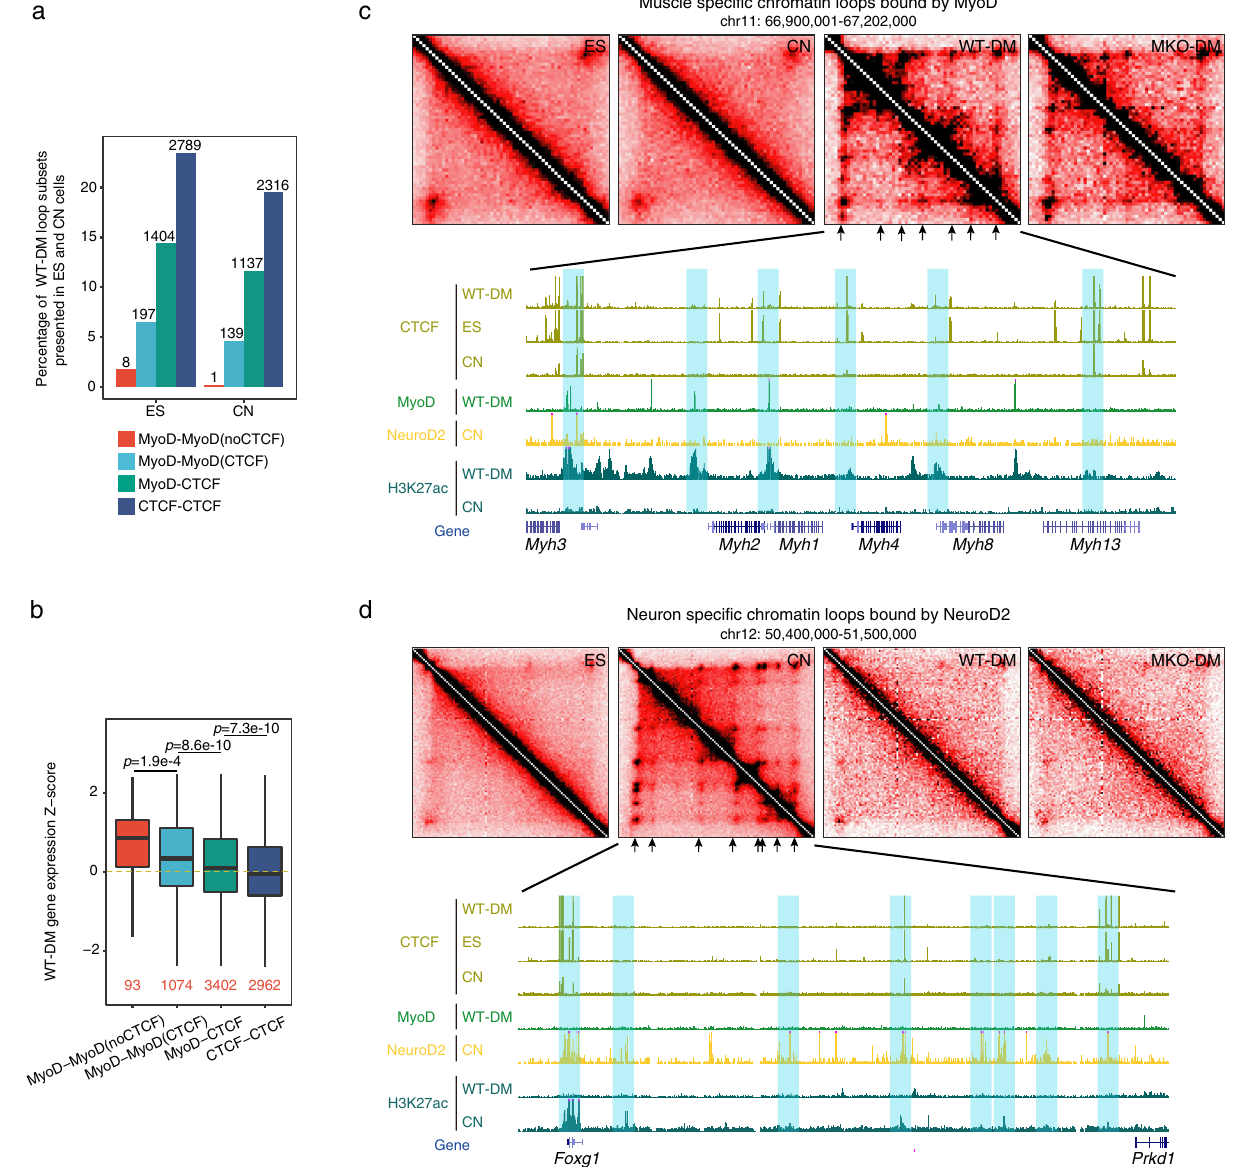
Fig. 4 MyoD anchors the formation of myogenesis-speci fi c chromatin loops. a Proportions of muscle chromatin loop subsets present in embryonic stem (ES) or cortical neurons (CN) cells. The numbers of muscle chromatin loops found in ES or CN cells are indicated for each bar. b Boxplots represent the expression Z-scores obtained in WT-DM cells for genes associated with each class of loops. The Z-score of each gene in WT-DM cells was calculated versus those in other ENCODE-collected cell types (ES, spleen, B, T, megakaryocyte, neural progenitor, and CN cells). The loop-related gene numbers are marked in red. p -values were calculated by the one-sided Wilcoxon rank-sum test. Source data are provided as a Source Data fi le. c Representative region showing muscle-cell-speci fi c loops anchored on MyoD-binding regions at the Myh gene cluster. d Representative region showing neuronal cell-speci fi c loops anchored on NeuroD2-binding regions at the Foxg1